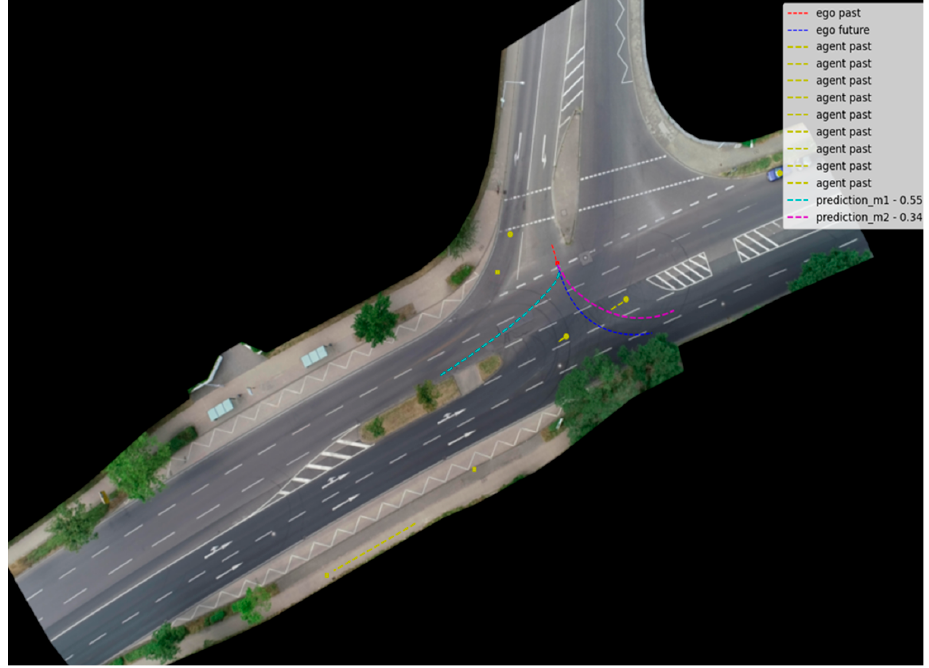
Figure 16. Traffic scene prediction with the multimodal approach. In this scenario, the car has the most probable maneuver with light blue (turning right) and the second one with magenta (turning left).